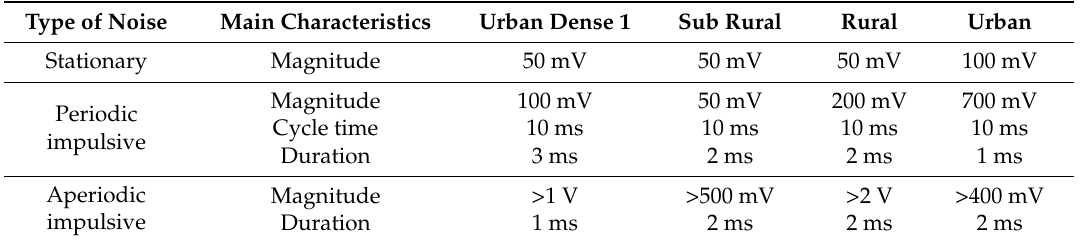
Table 3. Summary of the noise temporal features in various